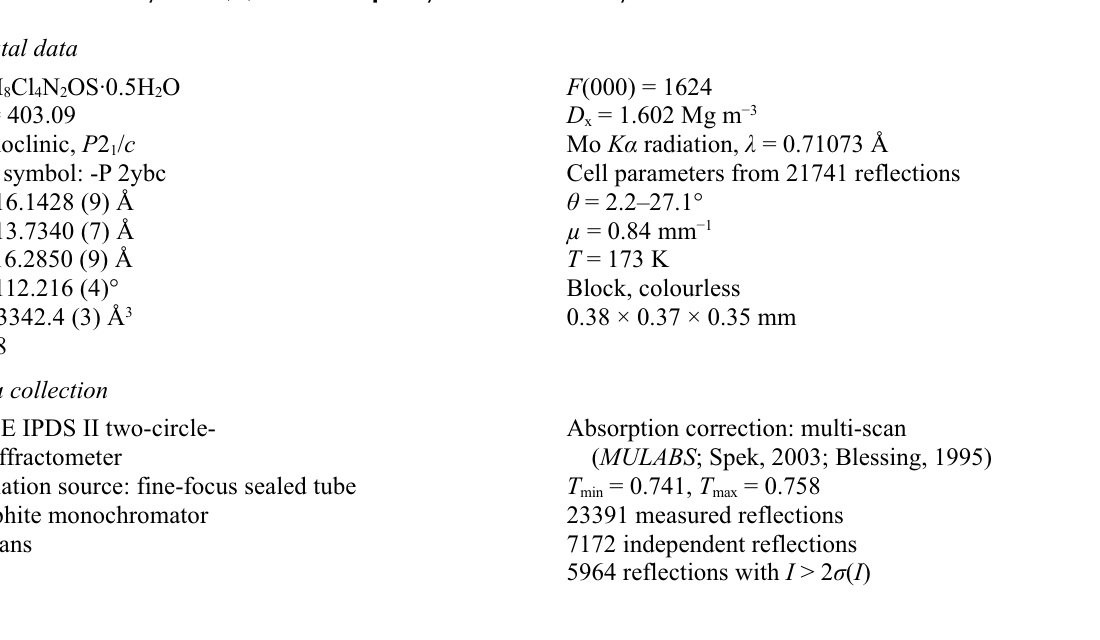
Packing diagram of